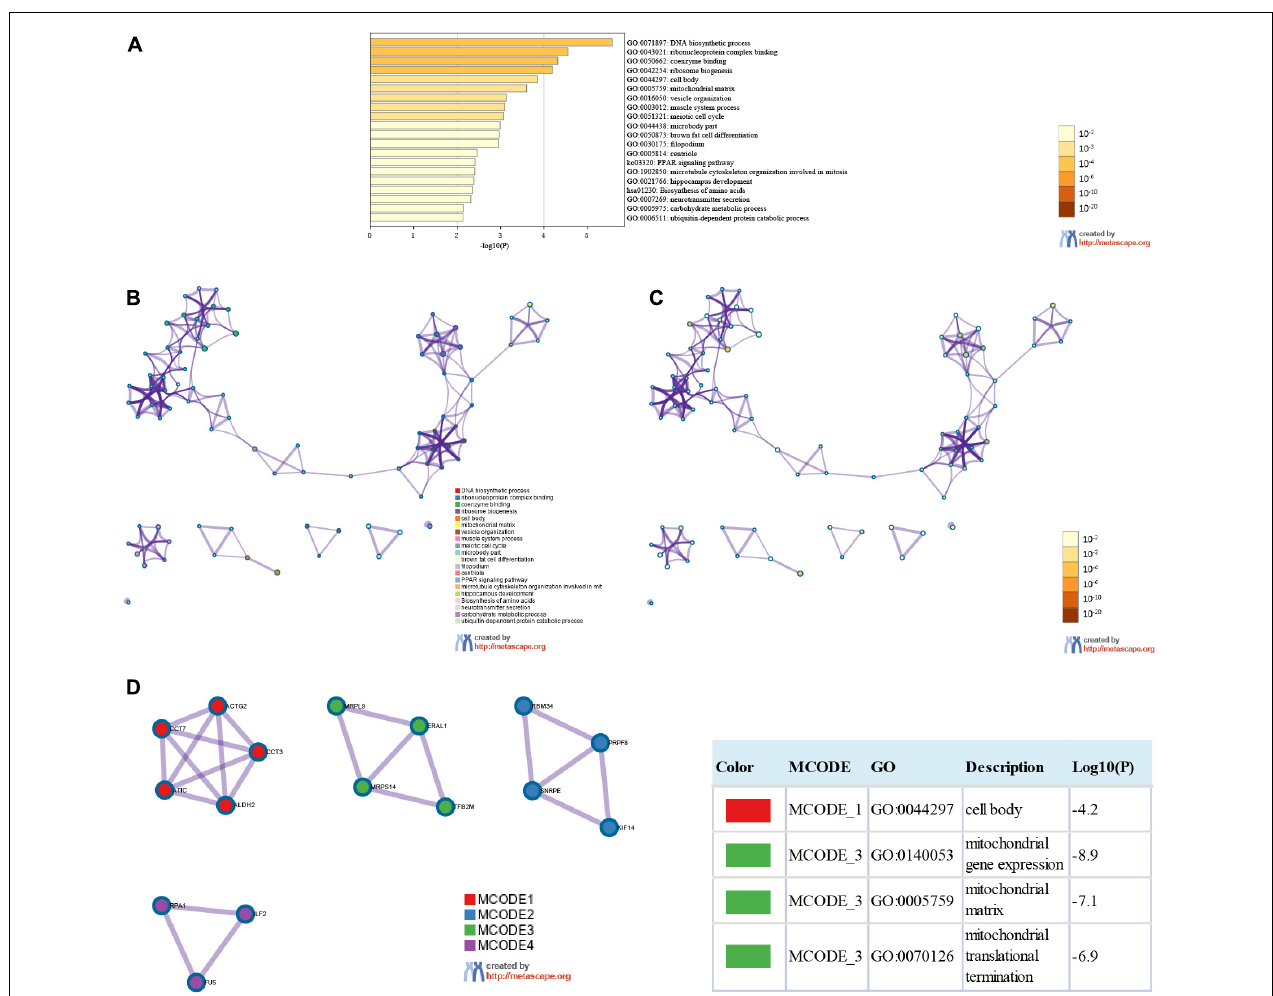
FIGURE 6 | Enrichment analysis of SMYD family members and related mutant genes in ESCA, LIHC, and STAD (Metascape). Heat maps of GO and KEGG enrichment analysis of SMYD family members and 124 adjacent genes related to their mutations were stained with P -value (A) . Term-enriched network: colored by cluster ID, where nodes sharing the same cluster ID are usually close to each other (B) , colored by P -value, terms containing more genes tend to have more significant P -values (C) . For the MCODE components identified in the protein–protein interaction network, the three best score items divided by P -value are used as the functional description of the corresponding components, which are represented by the grid diagram (D)